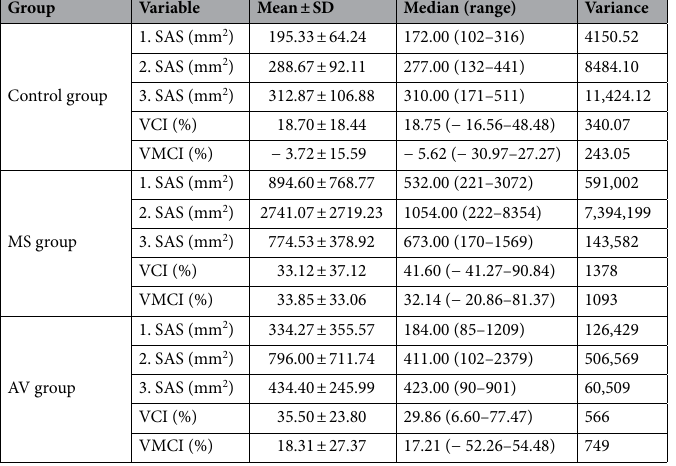
Table 1. Area of the stabilogram, vision control index and the vision-motion control index in all the measurements. SAS surface area of the stabilogram, AV atrial vertigo, MS multiple sclerosis, VCI vision control